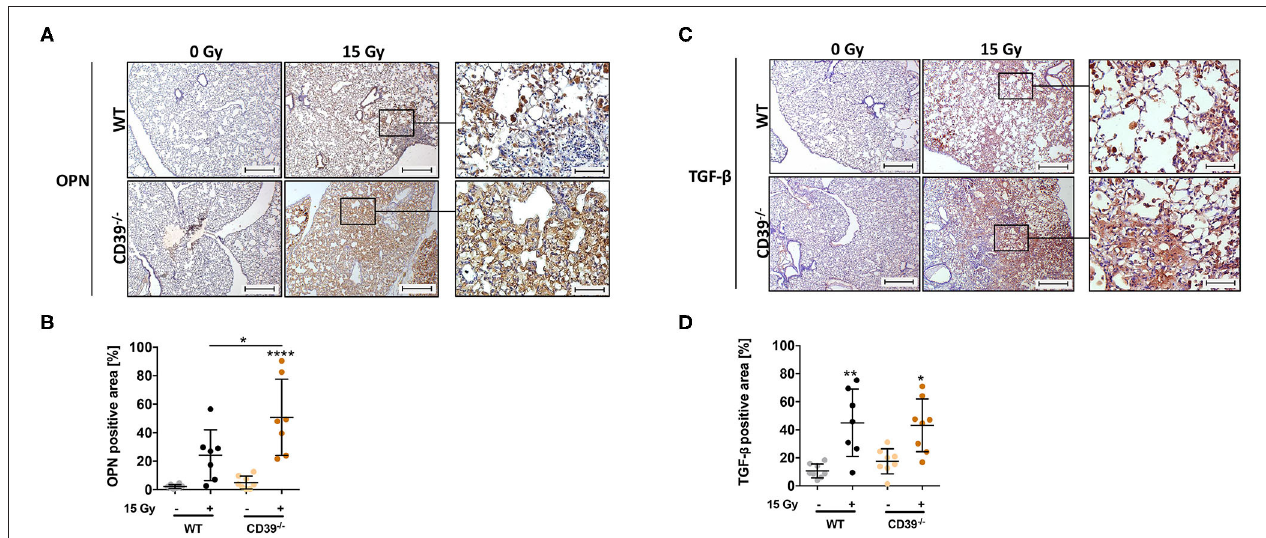
FIGURE 9 | A CD39 deficiency leads to an increased osteopontin expression and TGF- β accumulation after irradiation. C57BL/6 (WT) and CD39 − / − mice received 0- or 15-Gy whole-thorax irradiation (WTI) and were sacrificed at 25 weeks after irradiation. Immunohistochemical staining of paraffin-embedded lung sections with a primary antibody for (A,B) osteopontin (OPN) and (C,D) transforming growth factor β (TGF- β ). Shown in ( A,C right panels) are representative overview pictures of each indicated group (scale bar = 100 µ m, magnified pictures 400-fold). (B,D) Using the Software Orbit Image Analysis version 2.65, positive areas for OPN and TGF- β were analyzed and are shown in percentage of the whole lung section. * P ≤ 0.05, ** P ≤ 0.01, **** P ≤ 0.0001 by one-way ANOVA followed by post hoc Newman–Keuls test, n = 8/7/8/8.